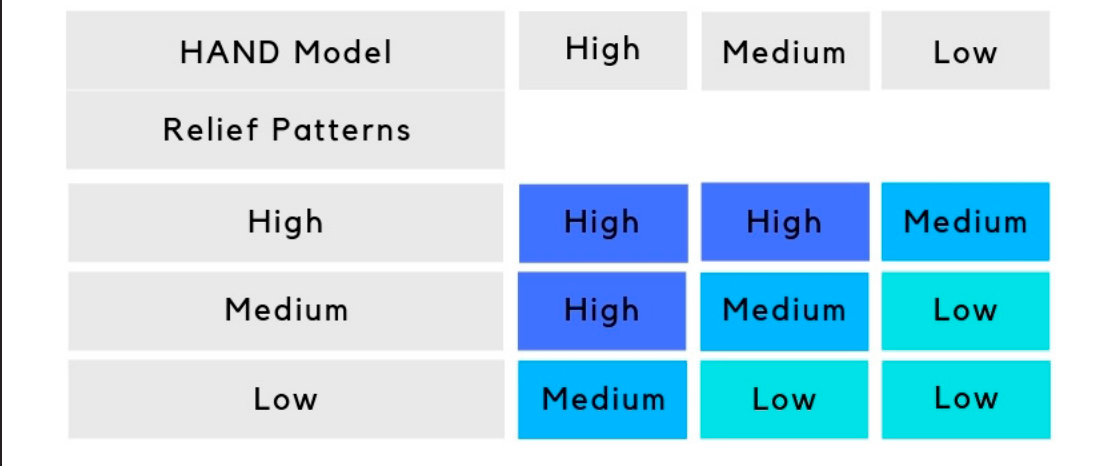
Figure 3 - Correlation matrix between the two susceptibility classifications obtained, according to the relief patterns and the HAND